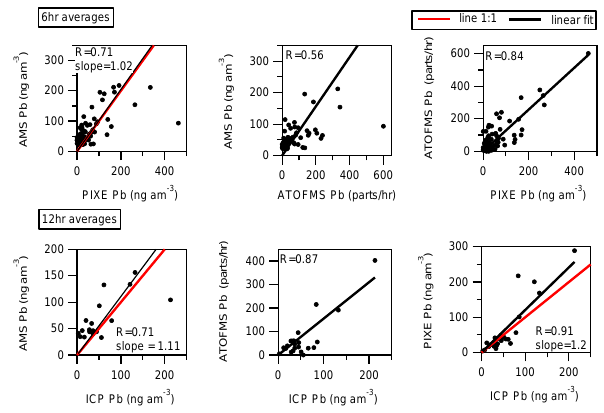
Fig. 9. Scatter plots and linear fits comparing the different Pb mass measurements at T0. Data was remapped into PIXE and ICP-MS time series (6 and 12h averages, respectively) for proper compar- isons. 1:1 and regression lines and regression slope values are shown where